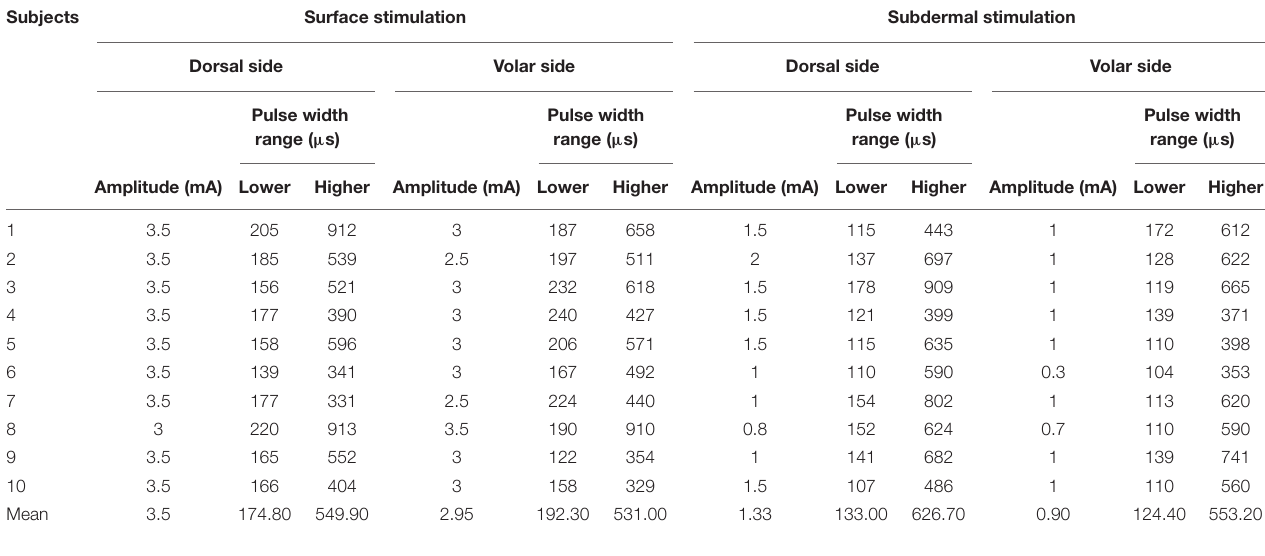
TABLE 1 | The stimulation amplitude and pulse width